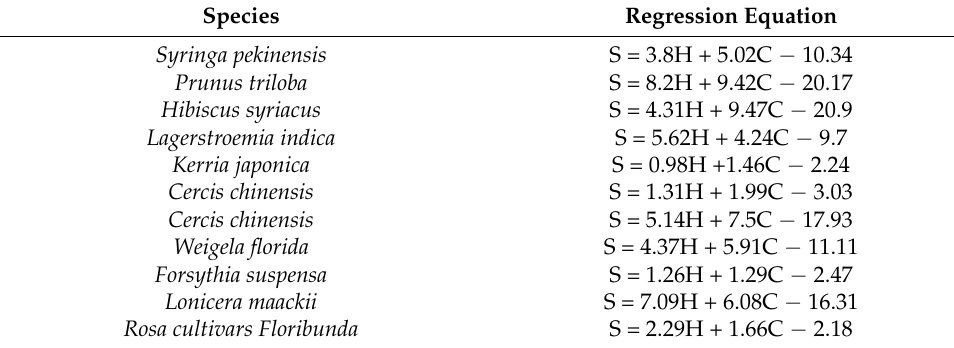
Table 3. Leaf area models of deciduous